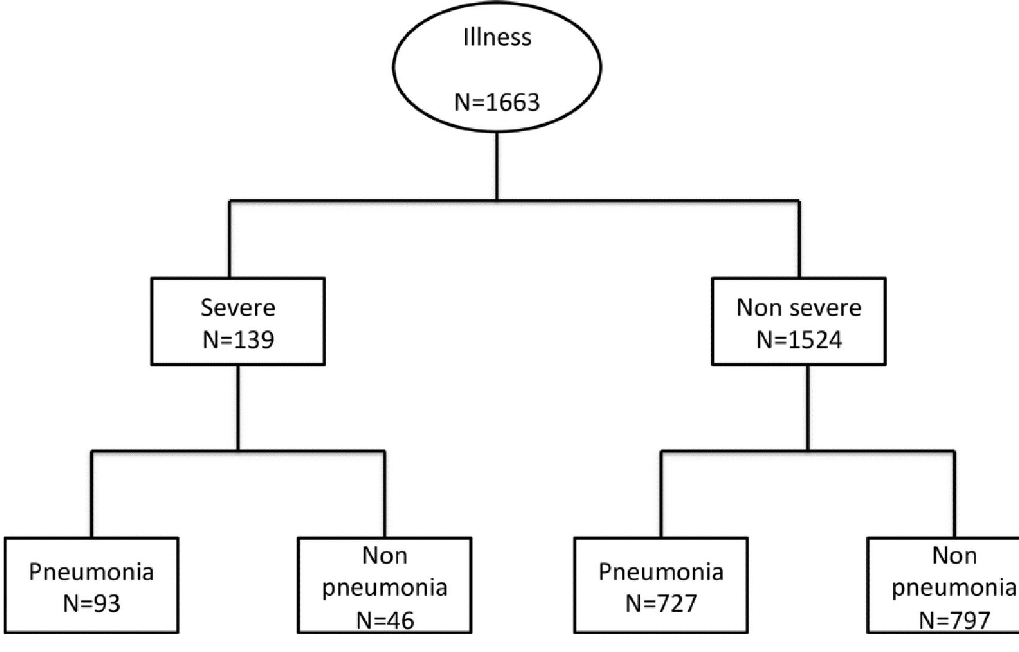
Fig 2. Classification tree of the illness